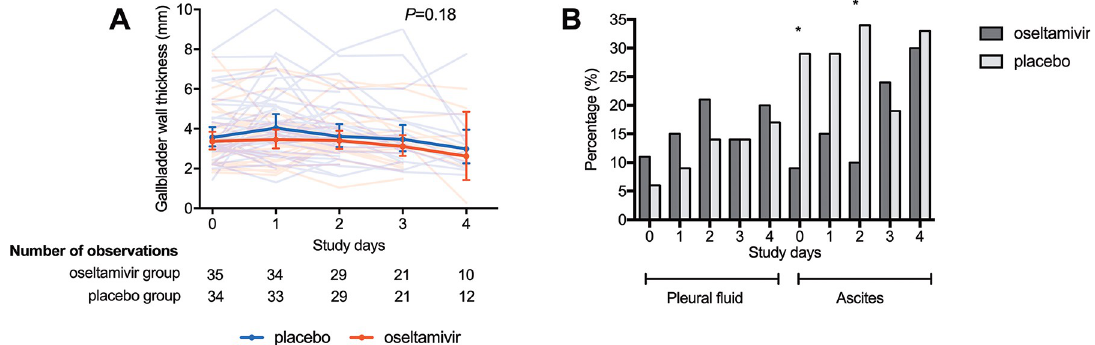
Fig 4. Daily gallbladder wall thickness and presence of pleural fluid or ascites. Gallbladder wall thickness and presence of pleural fluid or ascites was assessed daily by ultrasonography. Gallbladder thickness data are depicted as individual values (transparent lines) and geometric mean (solid line) with 95% confidence interval. P value for gallbladder thickness calculated using mixed model method. Differences in presence pleural fluid or ascites calculated using chi-square test ( � P < 0.05).